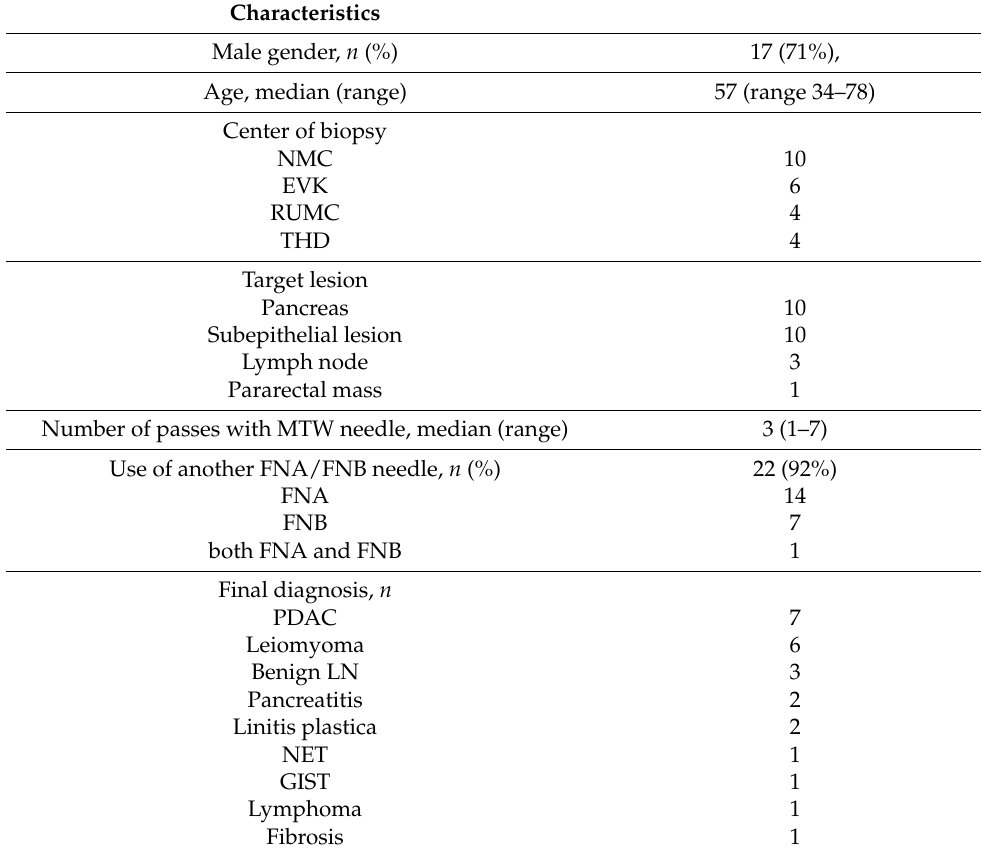
Table 1. Patient and procedure